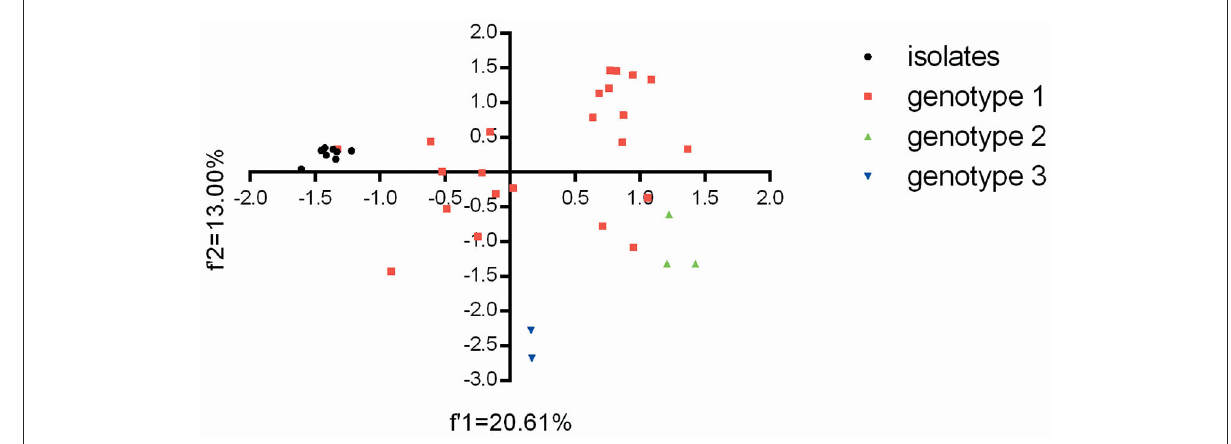
FIGURE2 The plot for the overall codon usage is visualized by the PCA method for these BVDV strains in this